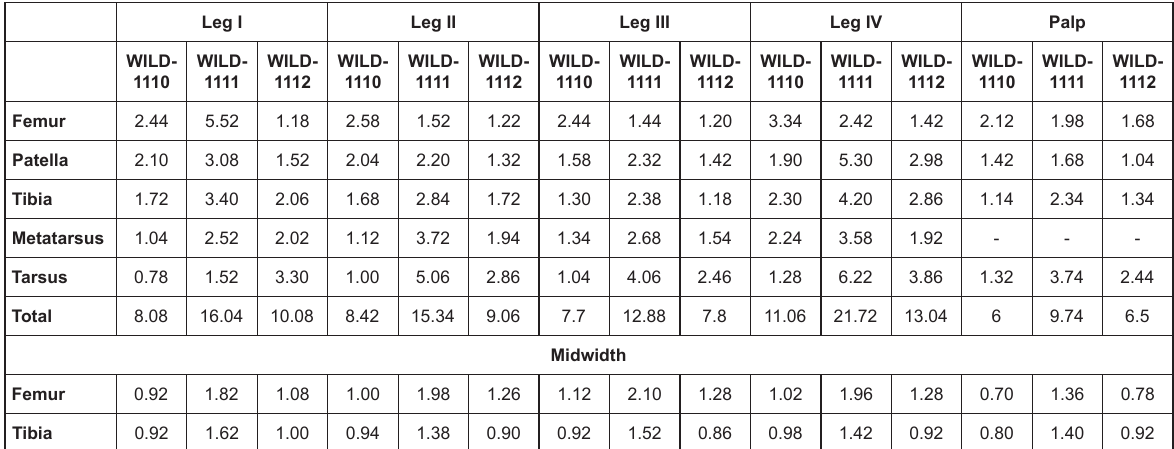
Legs and palp morphometry is provided in Table 3. Colour in life (Image 3): Carapace dark brown. Abdomen dark brown with faint yellow spots on dorsal and lateral sides (Fig. 8); ventral side yellowish-brown Spinnerets: PLS, with sparsely mottled (dark brown) on mid-ventral and